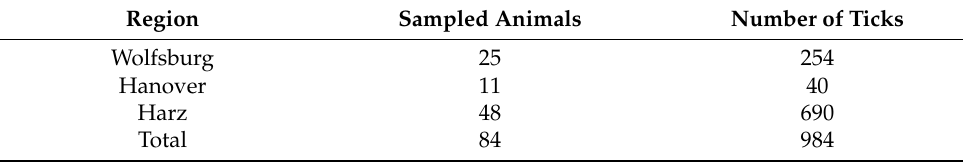
Table 1. Overview of sampled game animals and ticks per region. Region Sampled Animals Number of Ticks Wolfsburg 25 254 Hanover 11 40 Harz 48 690 Total 84